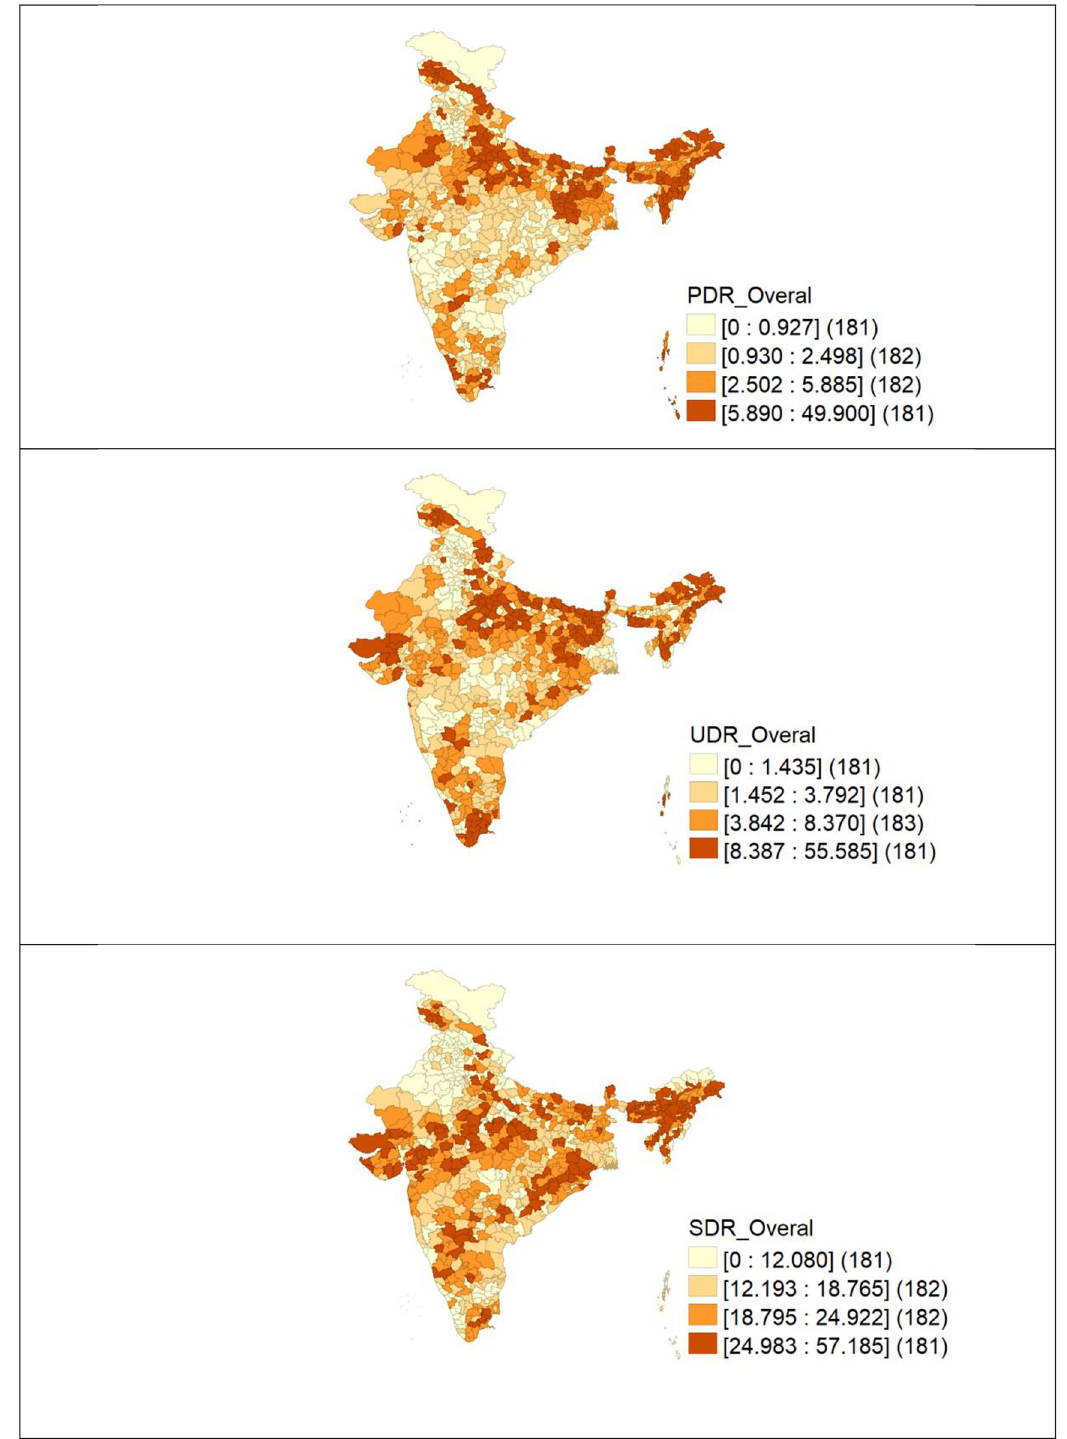
Fig 1. Rates of dropout across Indian districts. (A) Primary dropout. (B) Upper primary dropout. (C) Secondary.